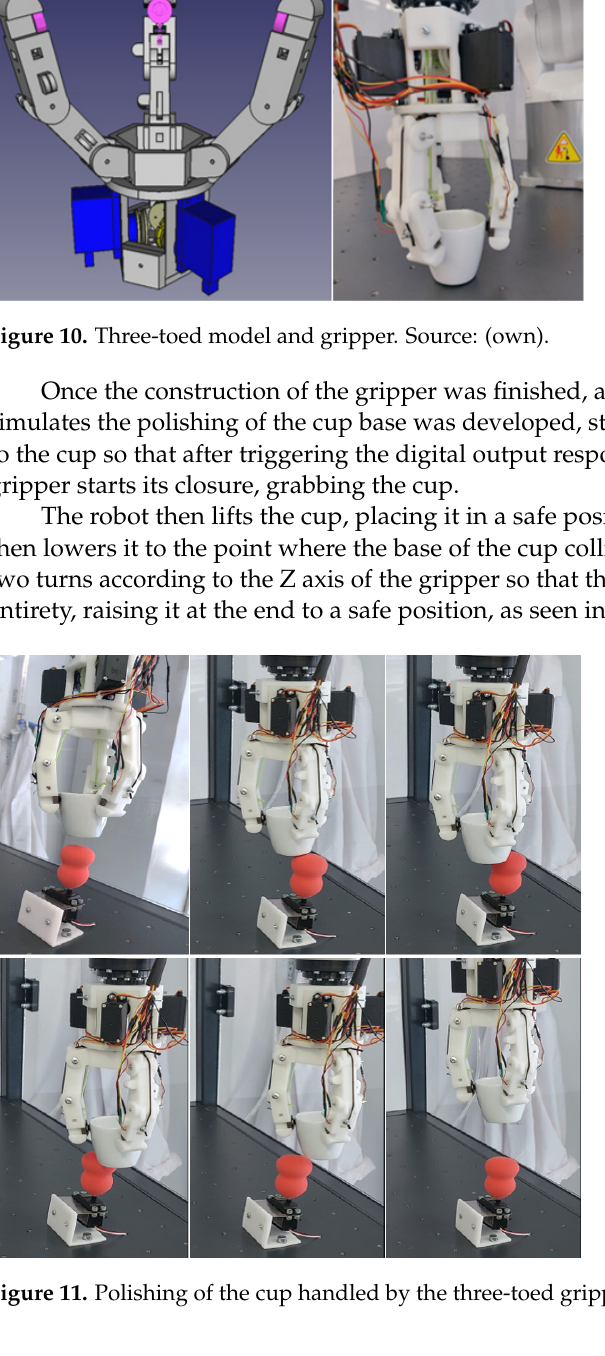
Figure 12. Display of the base of the cup. Source: (own). After a few seconds in this position, the robot puts the cup back in its original position, then returns to the start position of the program so that it is possible to perform an automatic loop. In the course of this test, the minimum load value for the gripper closure was adjusted to 1,568 N (or 160 g • f) and the values read by the sensors on the gripper fingers were higher than this value, proving the stability in its handling. The behavior of the gripper was tested in the face of the sudden change of the minimum value of the closing load force, and the maximum, which is two times the minimum value, was applied to the coffee cup. In this sequence, after the cup was grasped with the minimum force of 1,568 N, this value was then reduced to 0,507 N, presenting a reduction in the force exerted by the three fingers of the gripper, which in turn reduced to within the stipulated values. Then, the minimum load value was increased to 1,323 N, which once again caused the gripper fingers to act and exert more force on the cup. This value was reduced twice more so that only one or two fingers acted; that is, after reducing the minimum load to 0,559 N, it was expected that the values of the loads